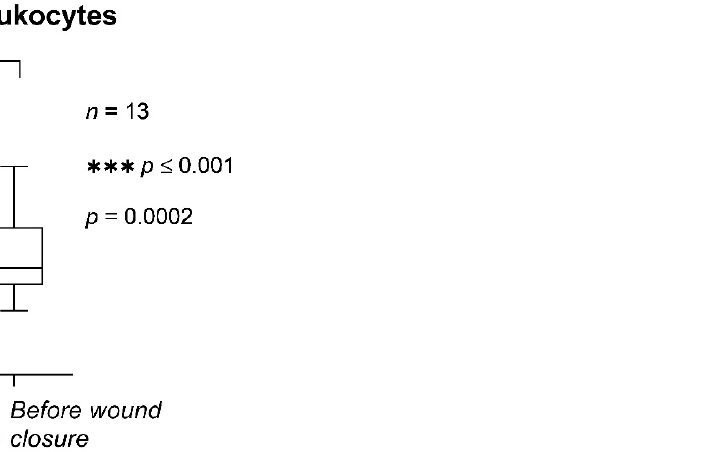
Figure 4. CRP levels before explantation and before wound closure. The horizontal lines mark the medians.